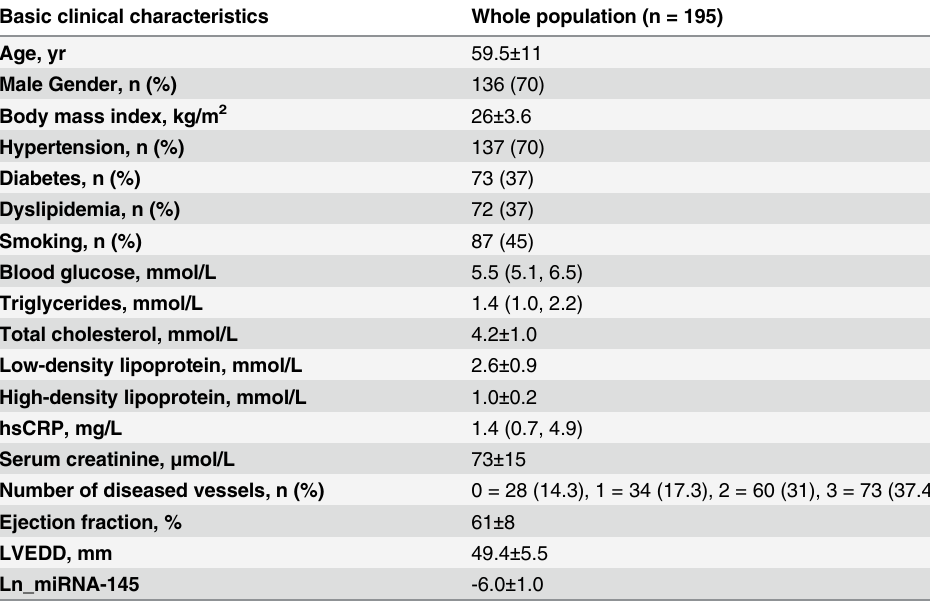
Table 1. Basic patient characteristics in the whole population.